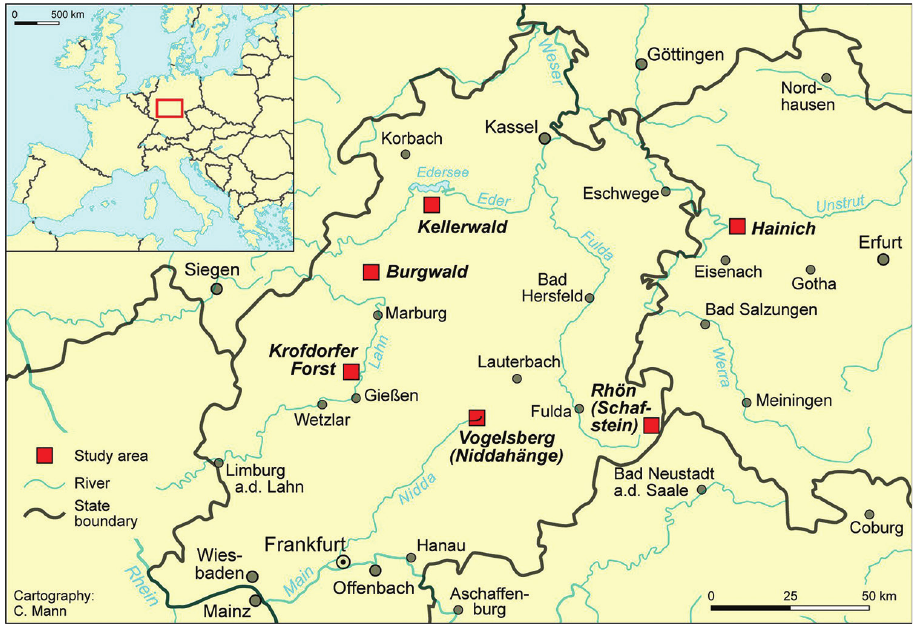
Figure 1. Study sites in Central Germany. Table 1. Overview of the study sites within deciduous forest land cover. Deciduous Forest Hainich Vogels-berg Geology Limestone Greywacke, Clay Shale Volcanic rocks